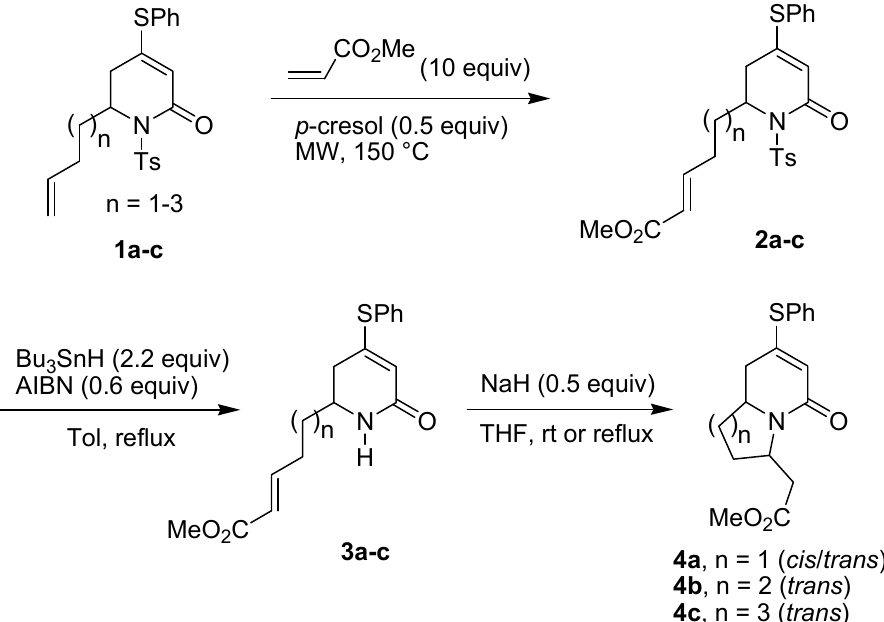
Figure 1. Proposed structure of quinolizidine